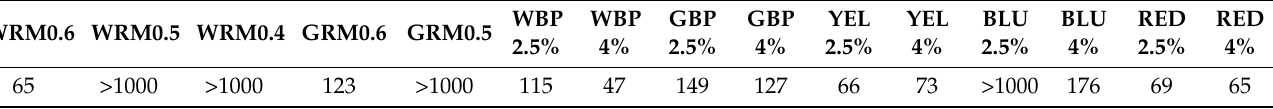
of the carbonation depth is lower. At early stage, the C di has a small value, and a small difference has a huge impact on R C65 . Table 5. Values of carbonation resistance for each mortar, RC65 (kg · year/m 5 ). Table 5. Values of carbonation resistance for each mortar, RC65 (kg·year/m 5 ).